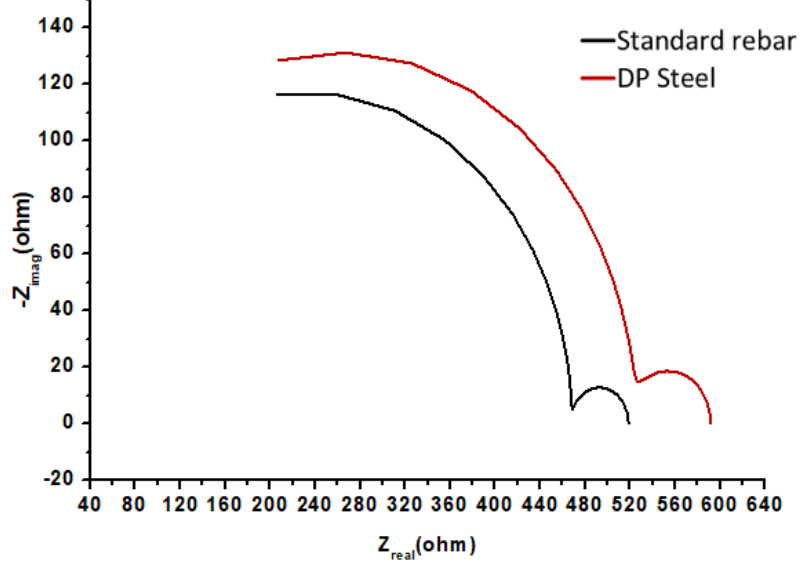
Figure 9. Potentiodynamic polarization results for standard rebar and DP steel in 0.3 M NaHCO 3 + 0.1 M Na 2 CO 3 (pH = 9.0) solution.